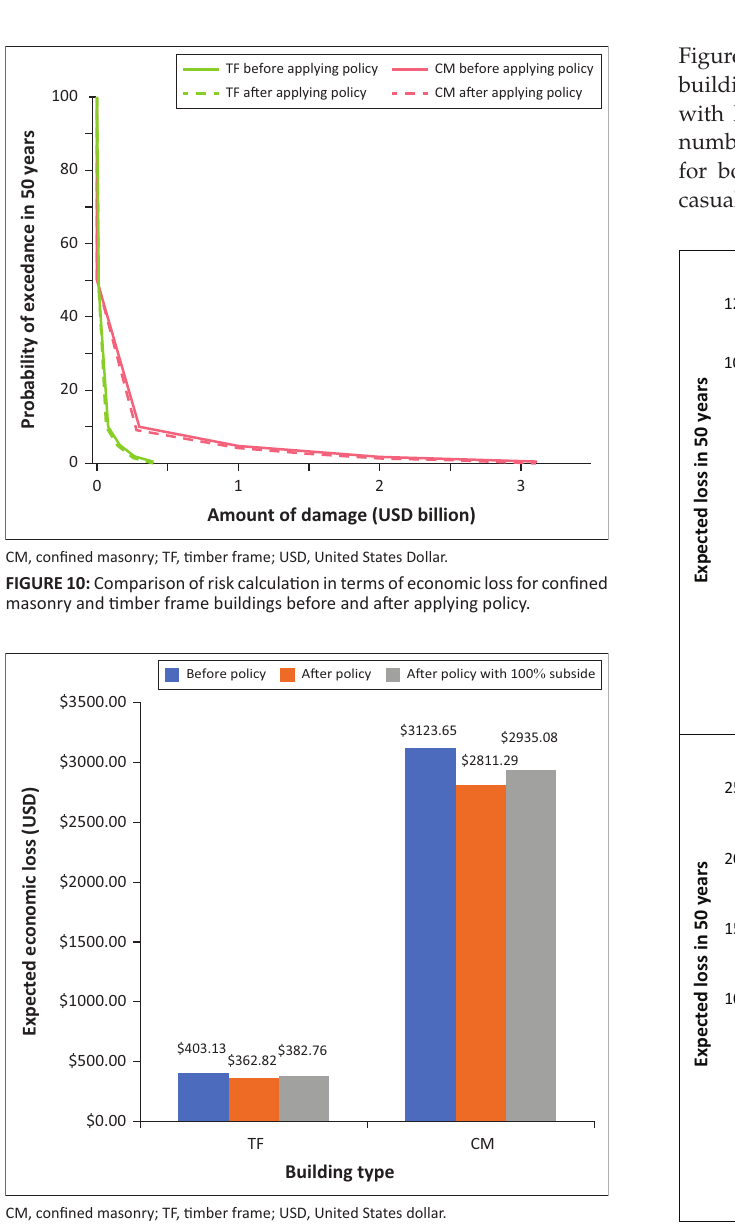
FIGURE 13: A comparison of casualty reduction in expected loss of lives for (a) daytime and (b) night-time earthquake scenario.